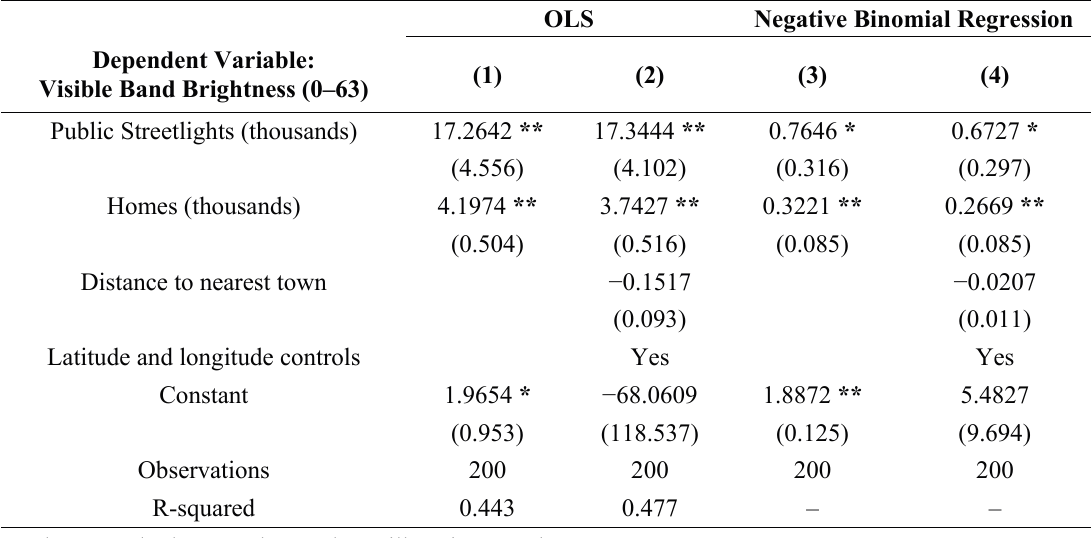
Table 6. Determinants of nightly DMSP-OLS light output. Data from 200 Vietnam villages and F18-2012 annual composite time stable night